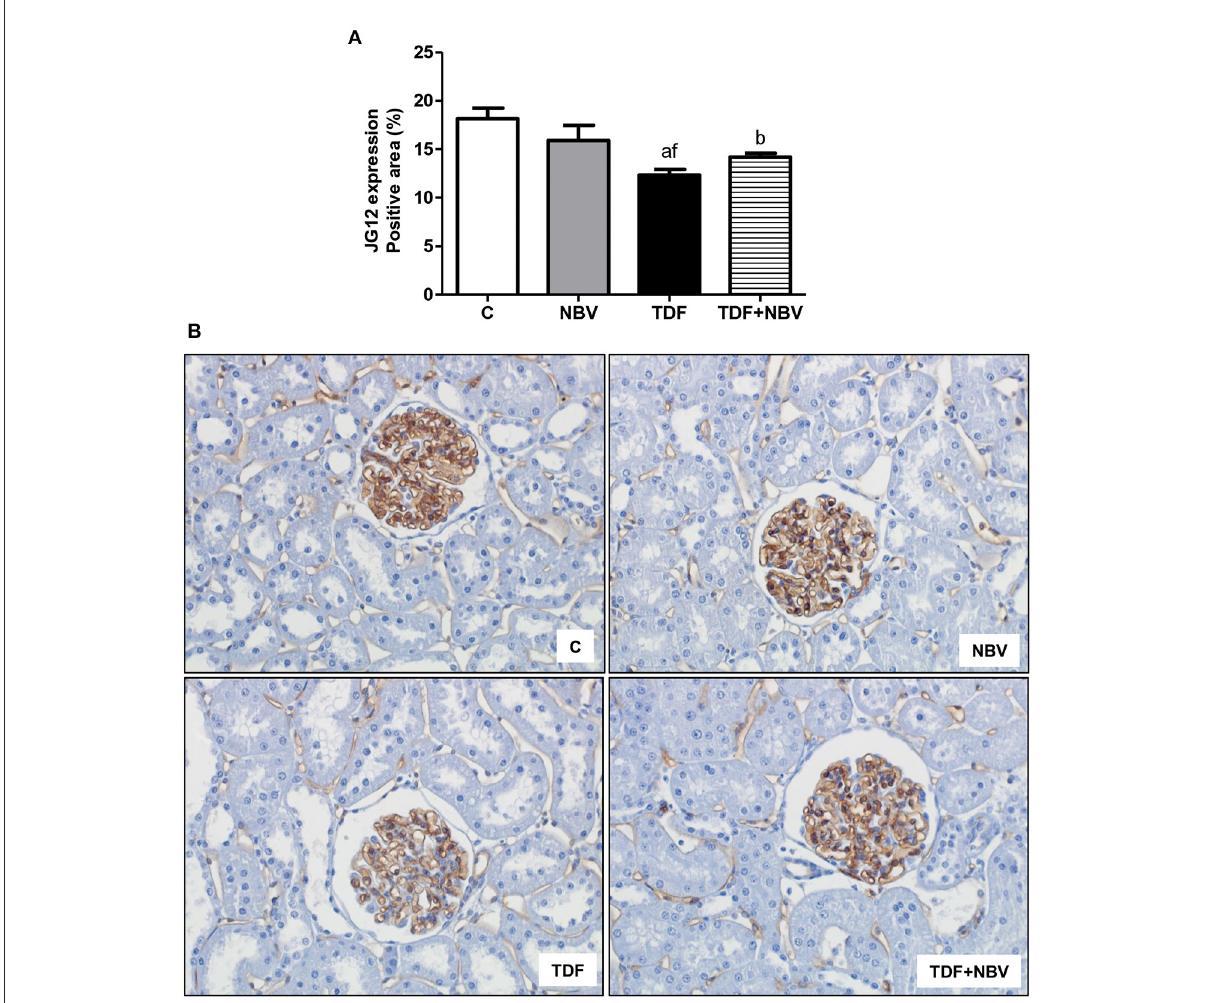
FIGURE2 Immunohistochemical analysis for aminopeptidase P (JG12) expression by glomerular tuft area in rat kidney tissue. (A) Bar graph of JG12 expression values. (B) Representative photomicrographs of immunostaining for JG12 from a C ( n = 7), NBV ( n = 7), TDF ( n = 8) and TDF + NBV ( n = 8) rat ( × 400). Values are means ± SEM. a p < 0.001, b p < 0.01 vs. C; f p < 0.05 vs. NBV. C, control; NBV, Nebivolol; TDF,